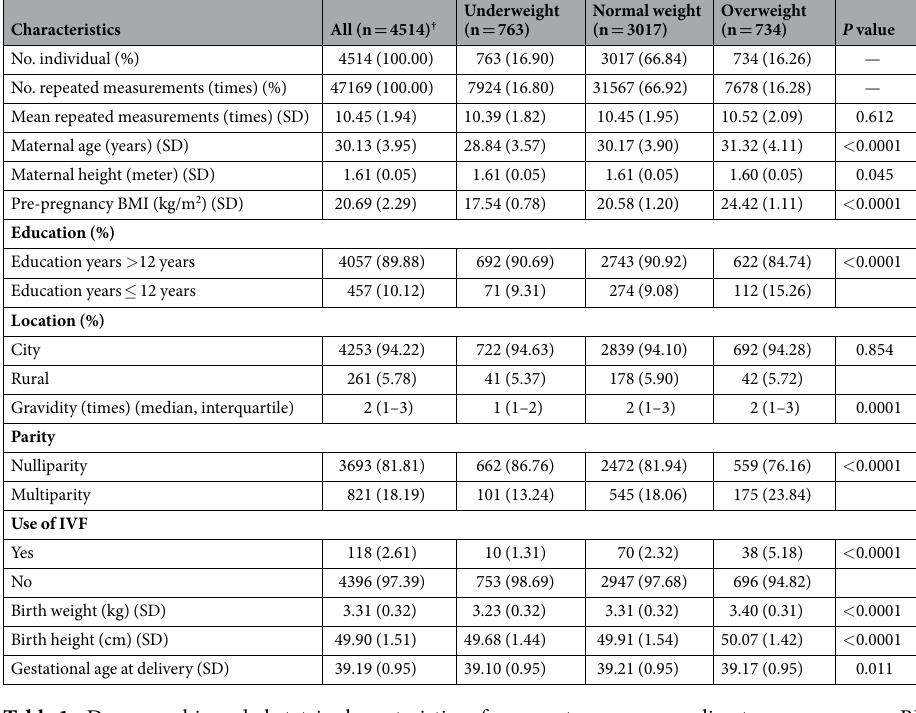
Table 1. Demographic and obstetric characteristics of pregnant women according to pre-pregnancy BMI categories. Notes: † Excluding 53 pregnant women with pre-pregnancy obesity (pre-pregnancy BMI ≥ 27.5 kg/